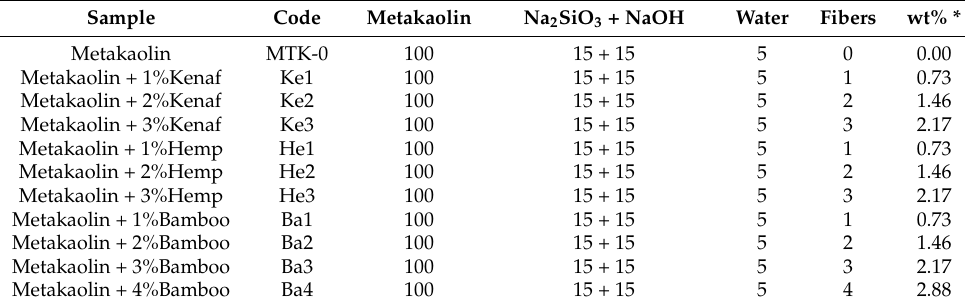
Table 1. Composition and labelling of the investigated